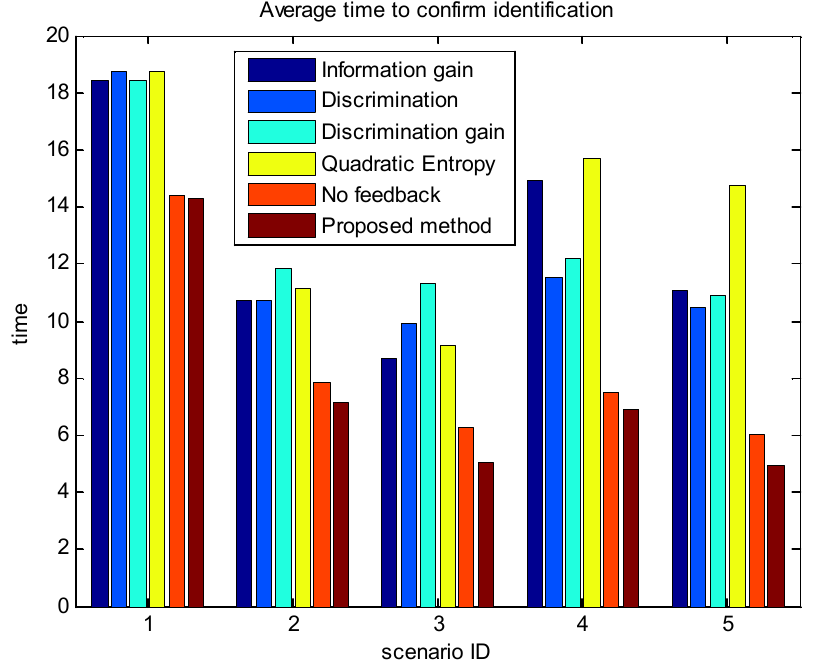
Figure 10. Comparison graph of correct recognition rate by various algorithms in scenario 5 under condition 1.